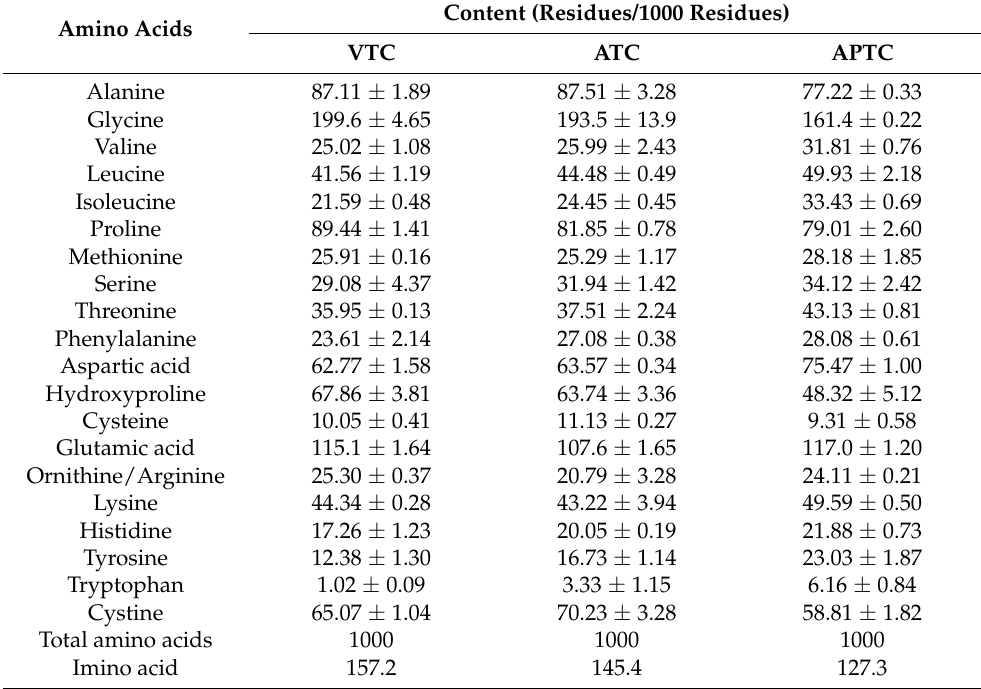
Table 5. Amino-acid composition of tuna-tail tendon